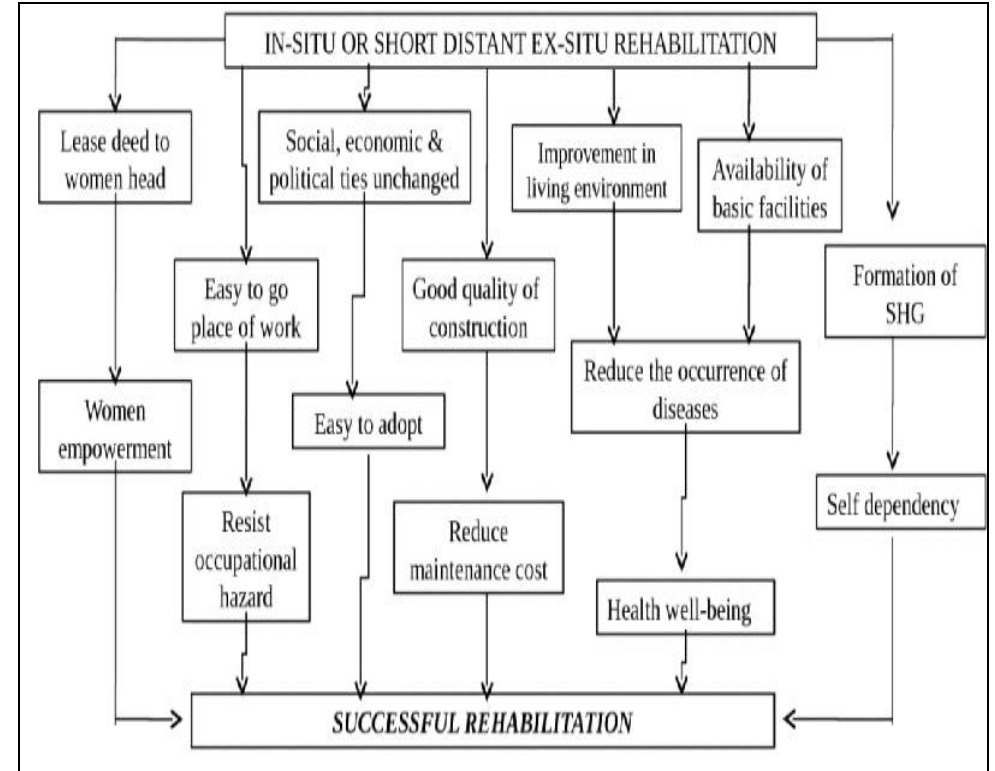
Fig. 1: Successful